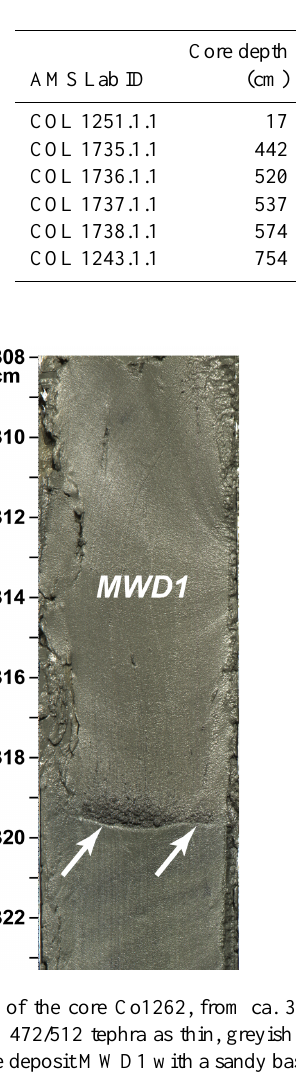
Table 1. Radiocarbon and calendar ages from core Co1262. The calibration of radiocarbon ages into calendar ages is based on Calib 6.1.1 (Stuiver and Reimer, 1993) and INTCAL09 (Reimer et al., 2009) and on a 2 σ uncertainty.